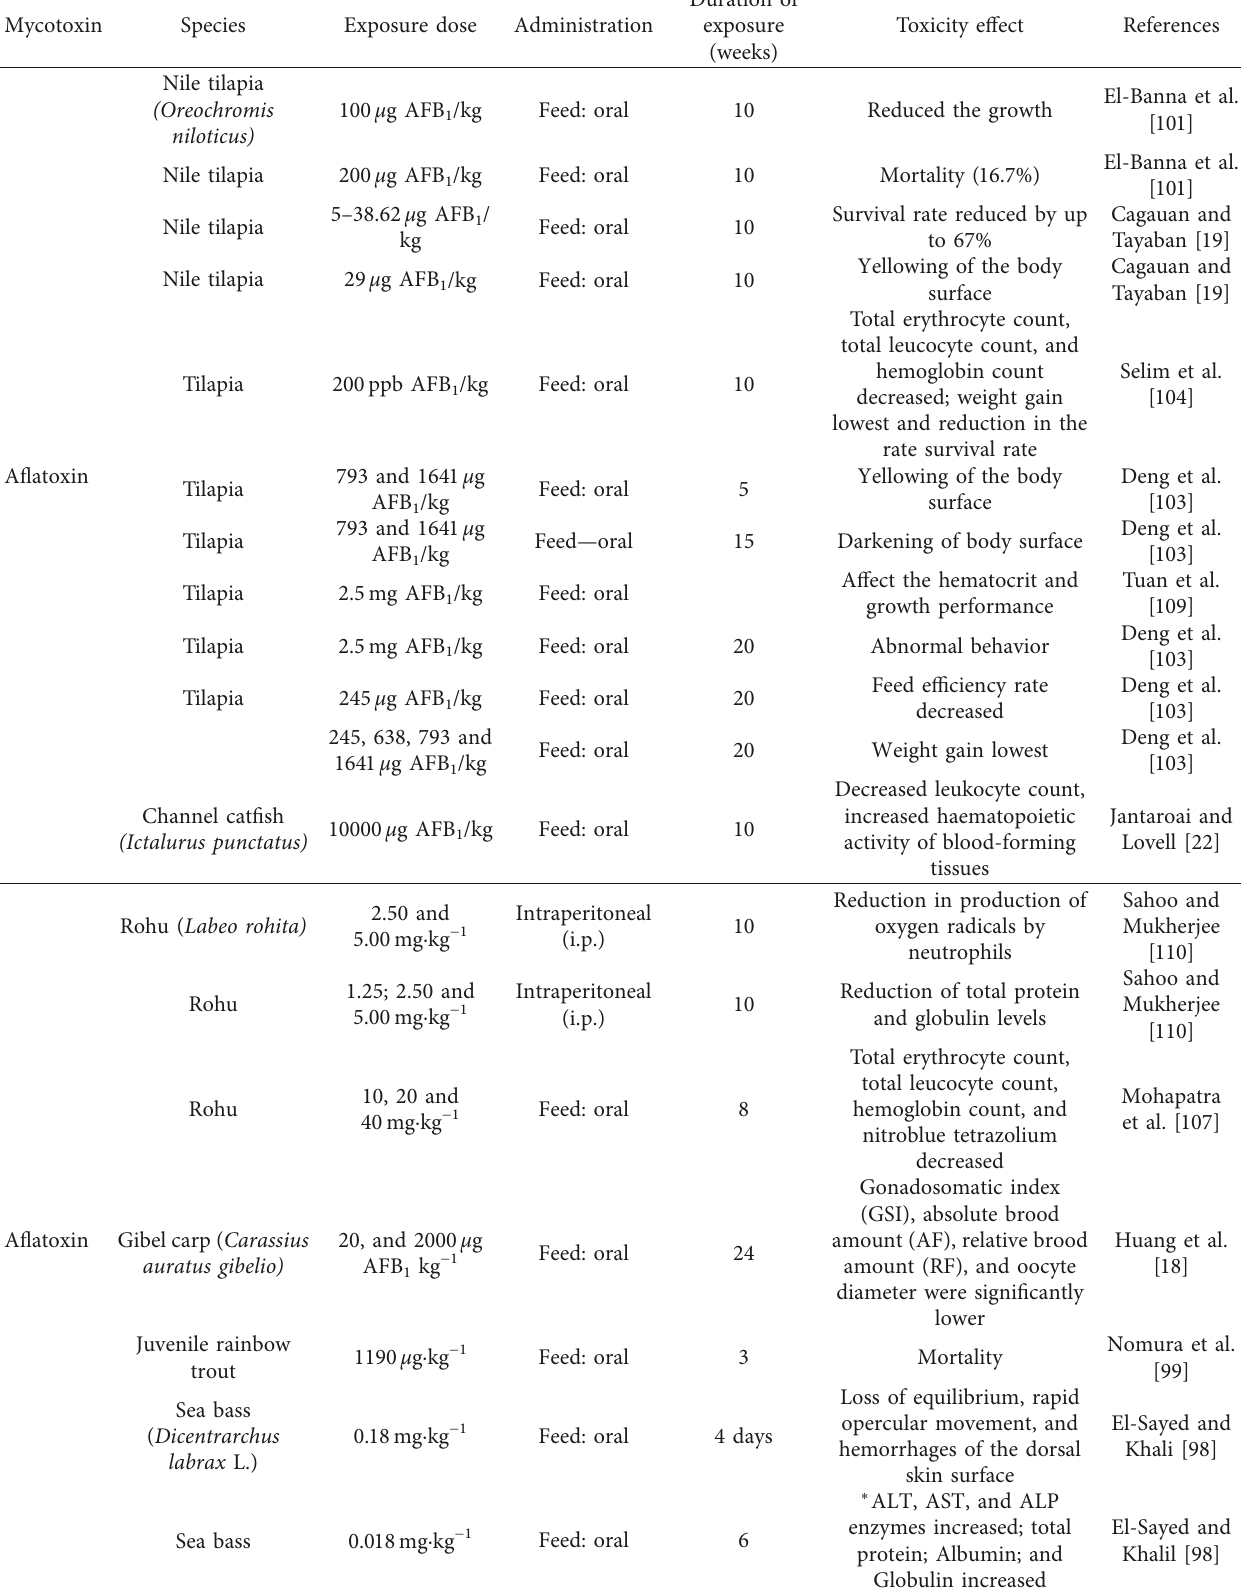
Table 3: Toxic effects of aflatoxins, ochratoxin A, and sterigmatocystin in different fish